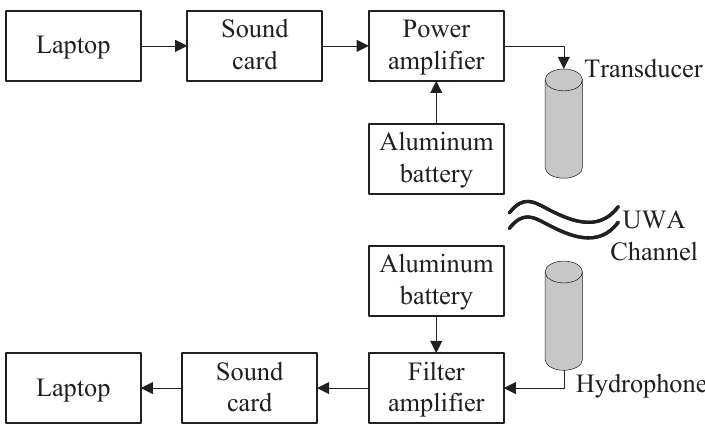
Figure 7. The overall system structure of the transmitter and receiver.